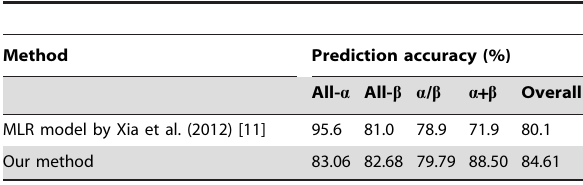
Table 6. Performance comparison of different methods on D1185 dataset.